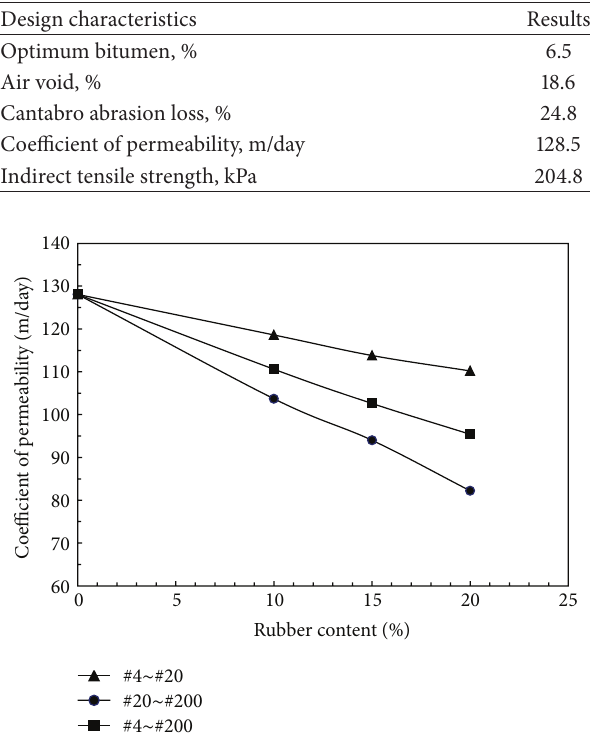
Figure 6: Effect of crumb rubber size and content on coefficient of permeability.